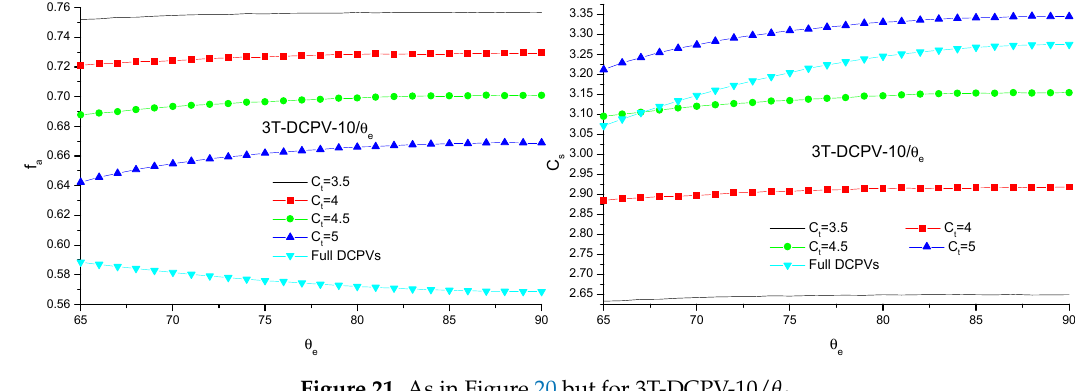
Figure 21. As in Figure 20 but for 3T-DCPV-10/ θ e . Figure 21 . As in Figure 20 but for 3T-DCPV-10/ e